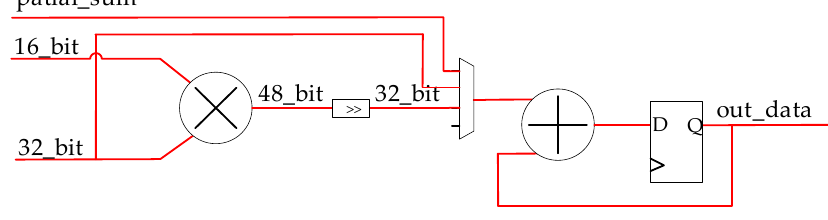
Figure 7. Data transmission of the convolution operation in PE.